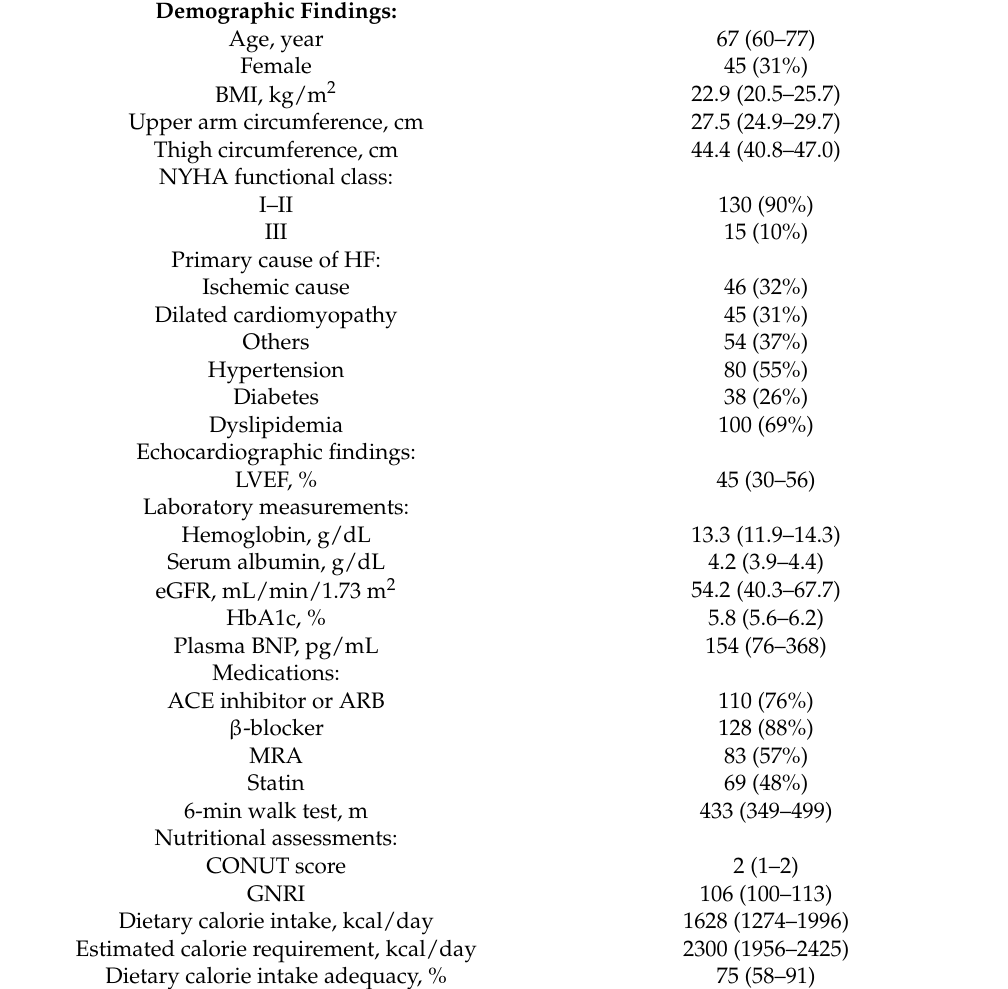
Table 1. Characteristics of total chronic heart failure (HF) cohort ( N =